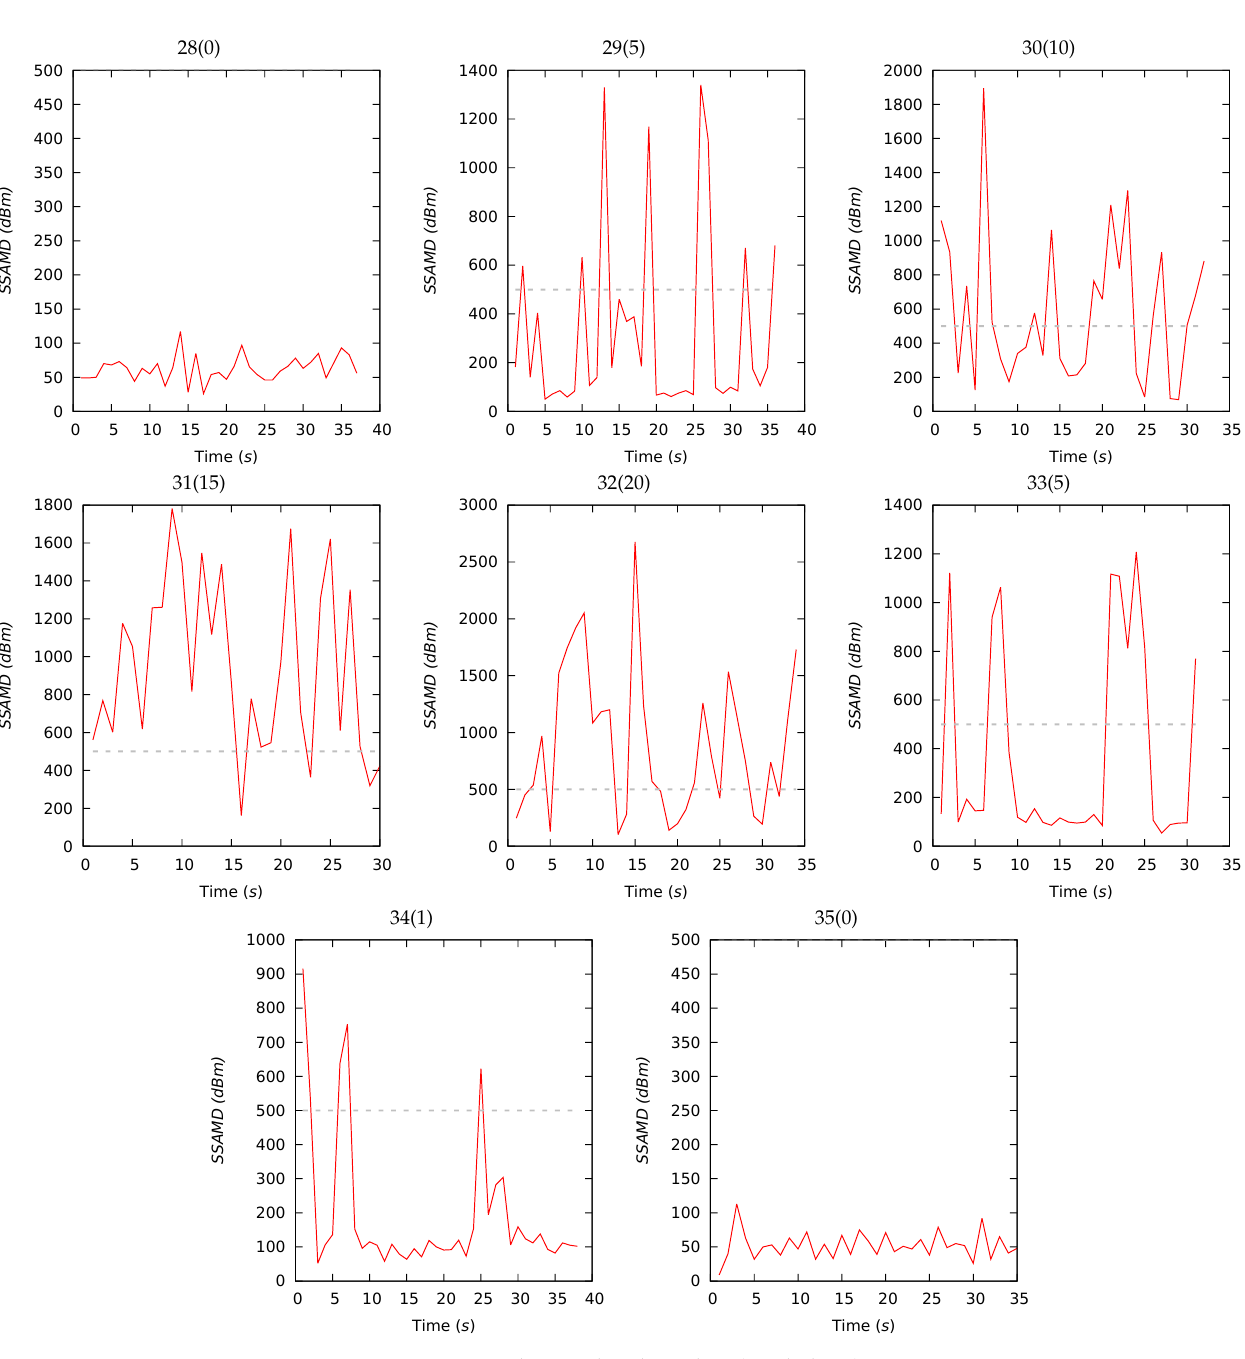
Figure 7. Crickets in the plastic box (no shaking). These conditions reflected well in Figure 7. The transparent box decreased the back- ground noise. As found earlier, the diffuser causes up to 400 SSAMD peaks, while the box created no more than 120. Furthermore, the figure illustrates that the insect led to wider spikes. This happened because a higher number of insects increases the probability of stronger reflection. SSAMD variations of the acts of Experiment IIIb ranged from 50 to 850. Figure 8 plots these values and shows the high correlation of SSAMD and the biomass; the correlation co- efficient is 0.97, which is much higher than in Experiment IIIa due to the lower